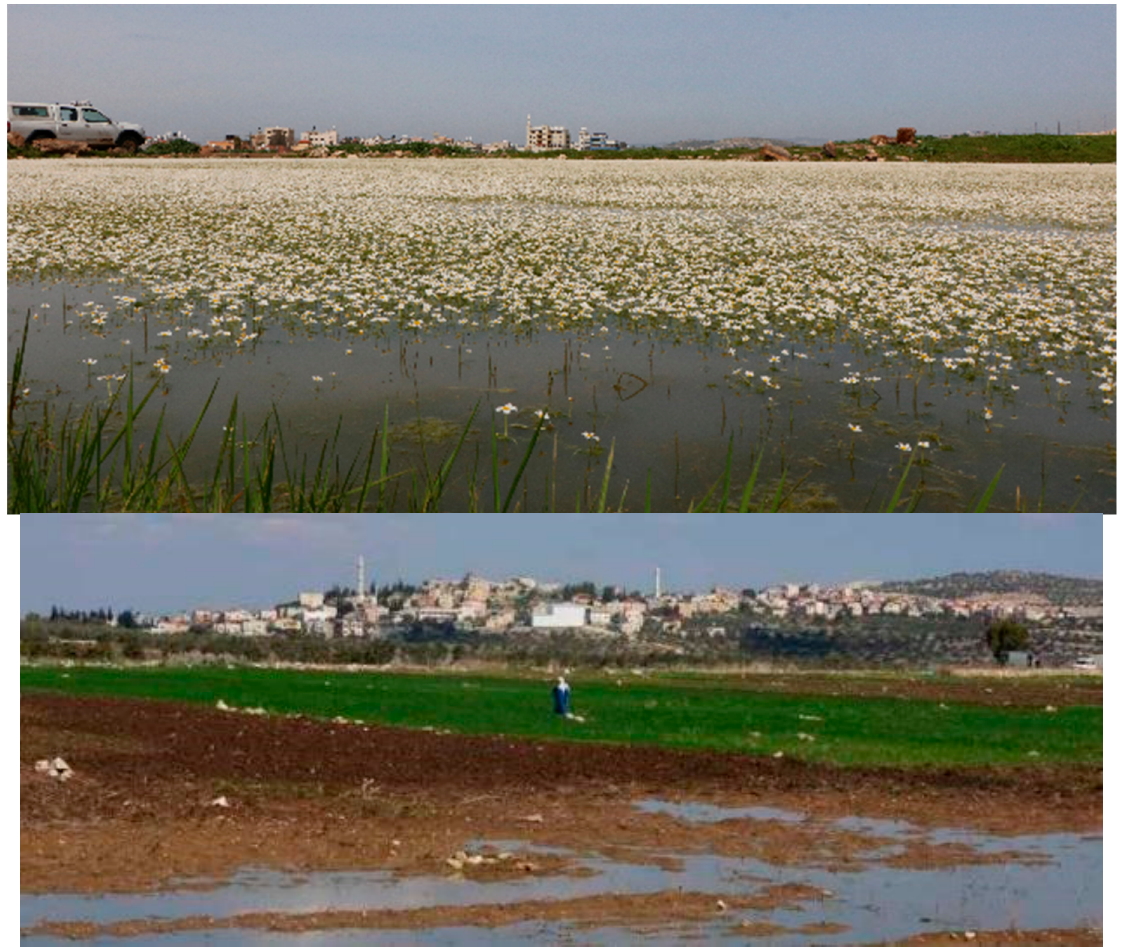
Figure 4. Temporary rain ponds in the buffer zones of the two protected areas. ( Top ), in Jinsafut near Wadi Qana, with the flowering rare plant Ranunculus peltatus , and ( Bottom ), in Deir Ballout near Wadi Zarqa, which has interesting crustaceans.